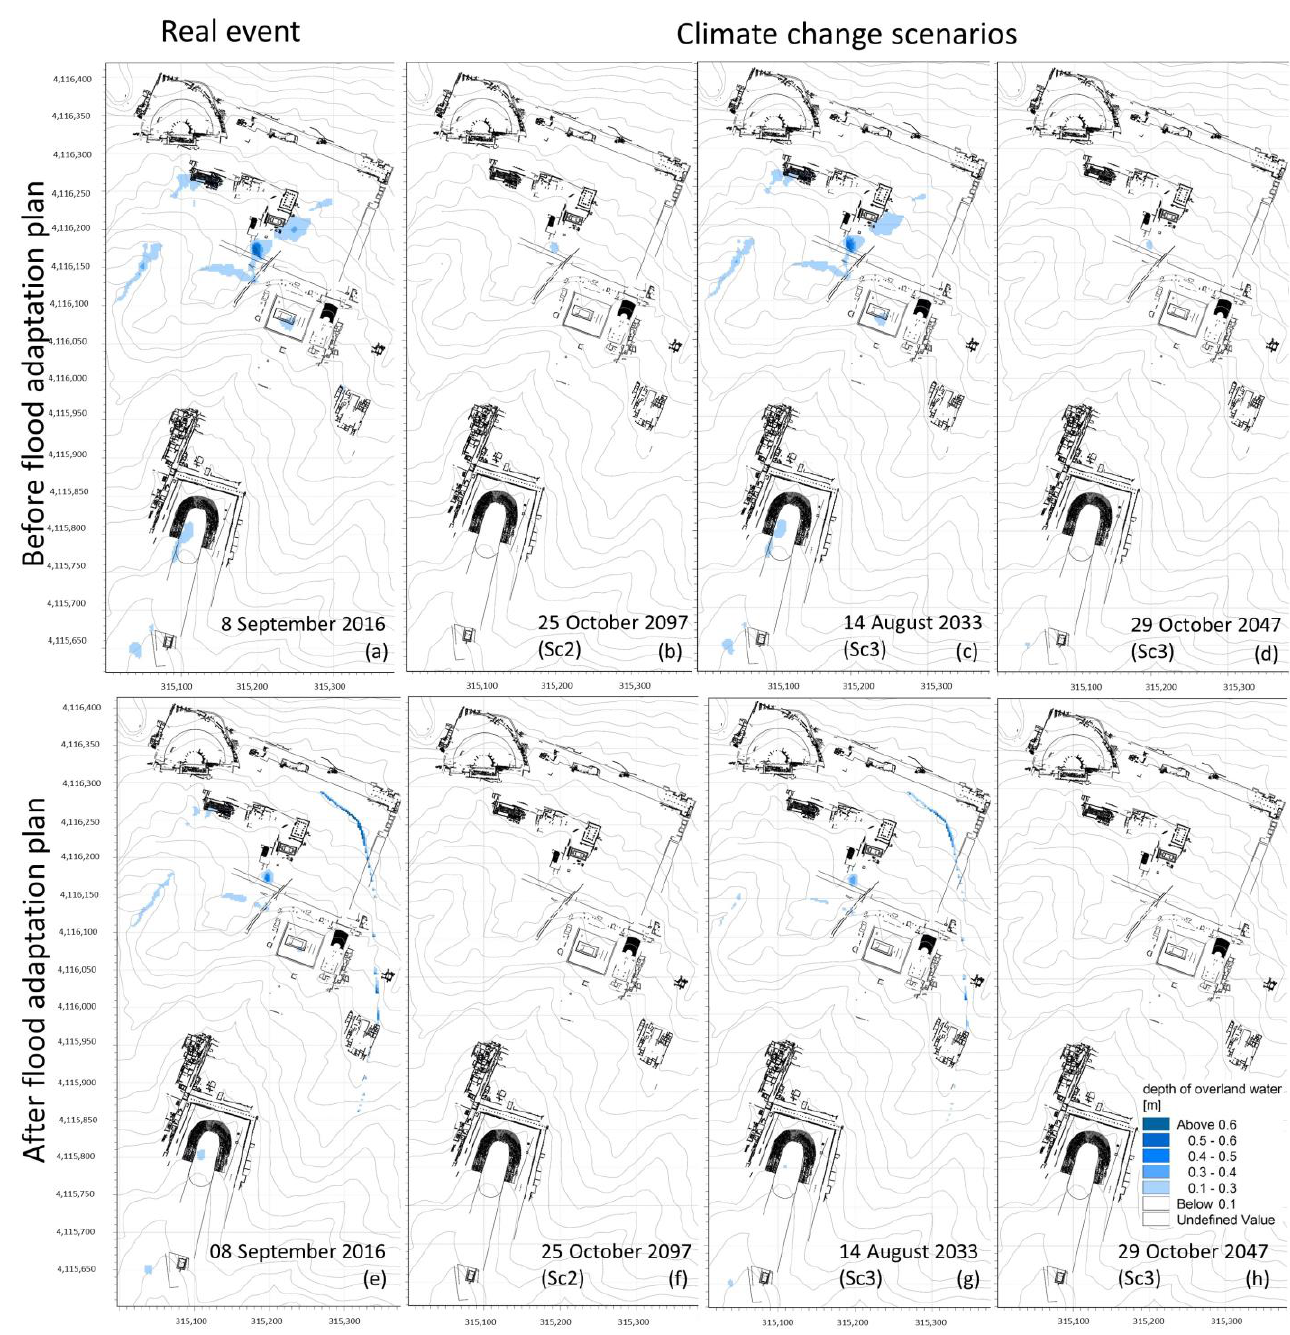
Figure 4. Results of the flood modeling—maximum water depth spatial distribution for the flood events examined before the flood adaptation plan ( a ) on 8 September 2016; ( b ) on 25 October 2097 (Sc2); ( c ) on 14 August 2033 (Sc3); ( d ) on 29 October 2047 (Sc3); and after the flood adaptation plan ( e ) on 8 September 2016; ( f ) on 23 October 2097 (Sc2); ( g ) on 14 August 2033 (Sc3); and ( h ) 29 October 2047 (Sc3).